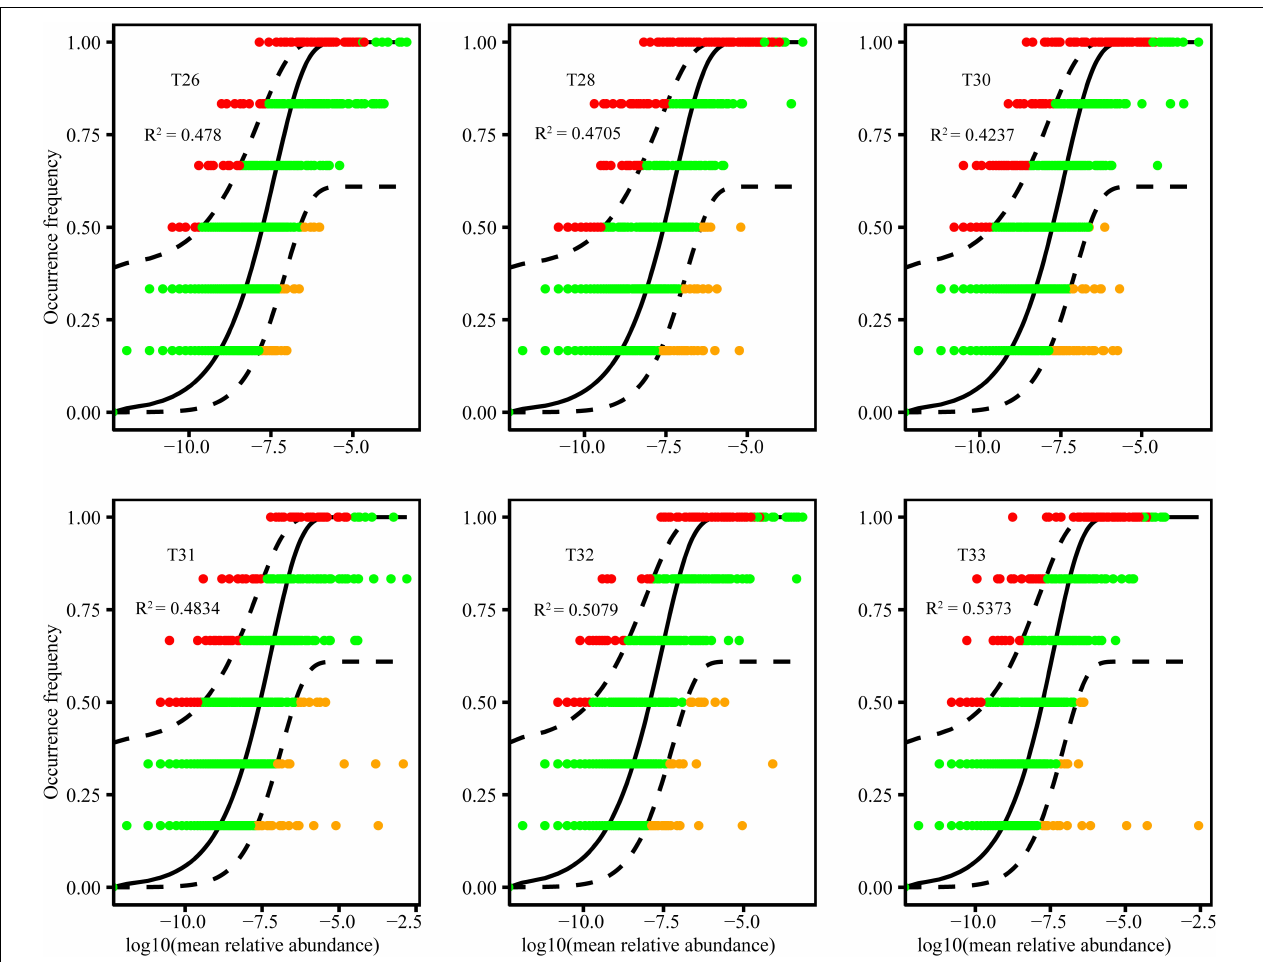
FIGURE 5 | The fit of the NCM of coral-associated bacterial community assembly at different temperatures. The blank lines indicate the best fit to the NCM, and the dashed lines represent 95% confidence intervals around the model prediction. R 2 indicates the goodness of fit to this